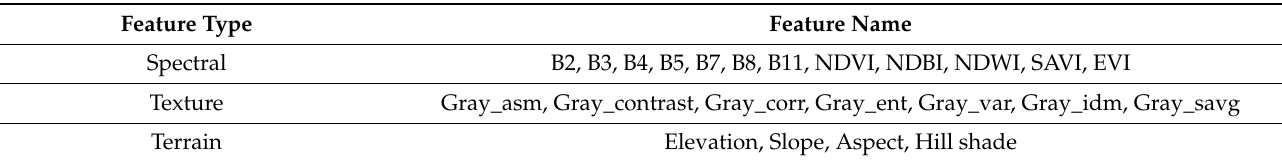
Table 3. The set of features in this